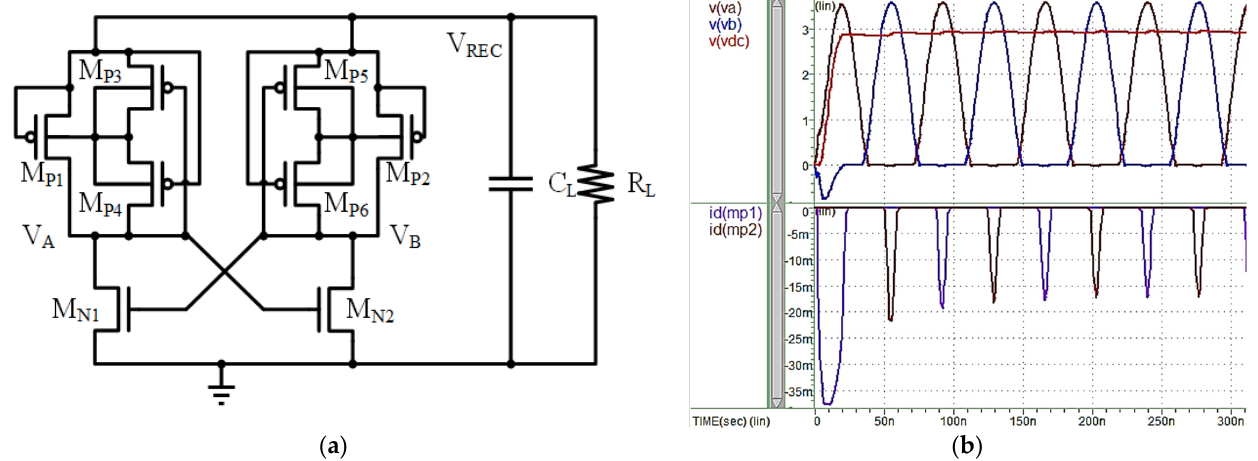
Figure 5. ( a ) Hybrid Rectifier Architecture. ( b ) Simulated Hybrid Rectifier. During the positive period, M 1 turns on and then activates the connection between the output and input terminals such that the signal source which ignores the possible resistance drop is set to the grounded voltage relative to V out -V in . If the input terminal pressure V in > V out , the input terminal voltage is lower than the ground. Thus, when the input voltage is lower than the ground for one V th , M 7,8 is turned on, conducting low voltage to the M 5,6 gate. This forces M 5,6 to open, and also pull up M 4 to the open state. Figure 6b shows the partial circuit of the positive half-wave cycle. The simulated pull-up for the active rectifier output results are shown in Figure 6c, while the state of each transistor in each half-wave cycle is shown in Figure 6d. When V in < V out , M 7,8 is off, and the pull-up PMOS transistor is used to connect the M 5,6 gate to the V out , and the M 3,4 transistor gate is driven by the same voltage. In the negative half-cycle, the same method is used, and these two rectifier circuits are used to achieve rectification. A frequency of 10 MHz and an input voltage Vp-p of 2.2 V achieves the best PCE of 79%, and the relationship between measured power conversion efficiency and input voltage scan is shown in Figure 6e.